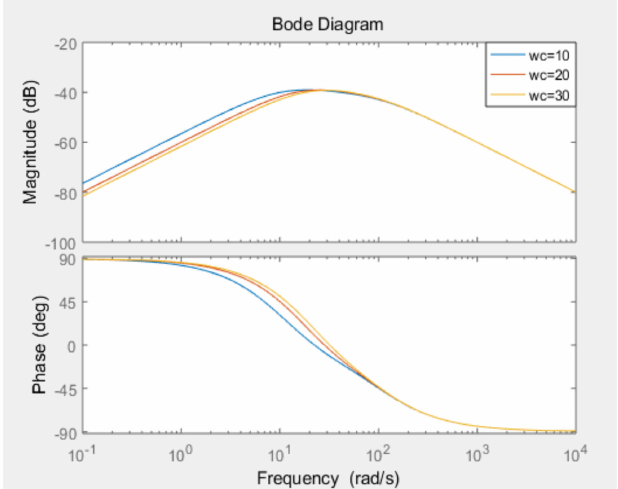
Figure 12. Bode diagram analysis of system disturbance term ( ω c increase).